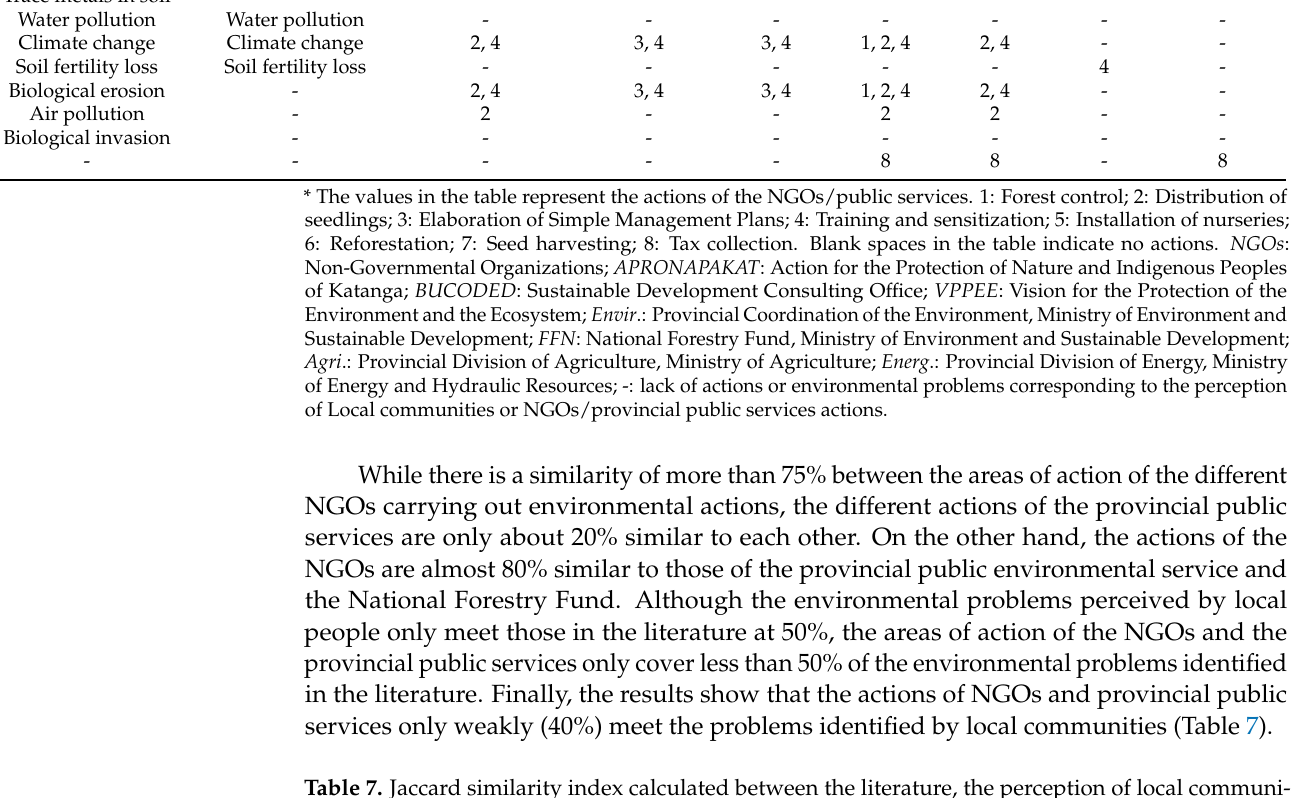
Table 7. Jaccard similarity index calculated between the literature, the perception of local communi- ties, and the actions of NGOs and provincial public